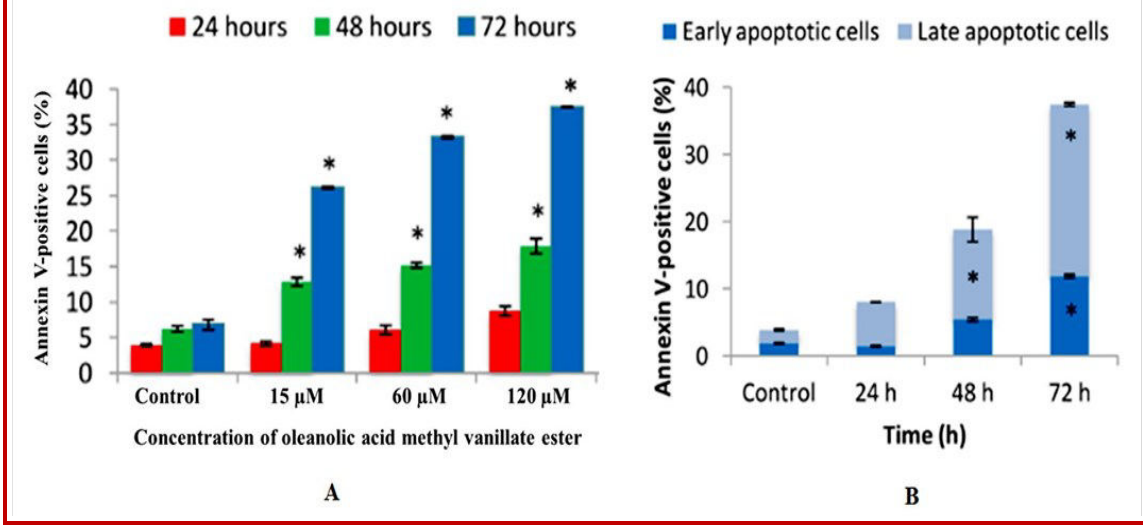
Figure 5: Annexin V/PI assay of oleanolic acid methyl ester-treated HeLa cell line by flow cytometry. After treatment for 24, 48 and 72 hours, cells were double stained with annexin V/PI for apoptotic analysis. (A) Induction of apoptosis by oleanolic acid methyl ester in a concentration-dependent manner at 24, 48 and 72 hours of treatment. (B) Induction of early and late apoptosis by oleanolic acid methyl ester at 60 μ M in a time-dependent manner. Results are represented as mean ±